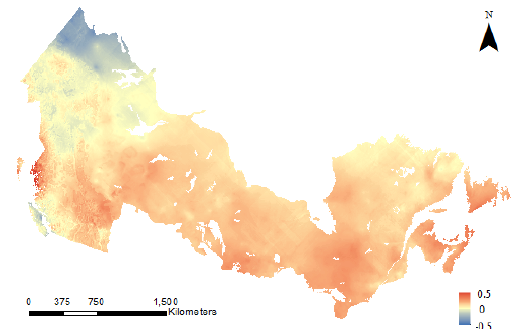
Figure 14. Spatial distribution of differences between the predictive SOC stock estimated from spatial error model parameters and interpolated SOC stock using Ordinary